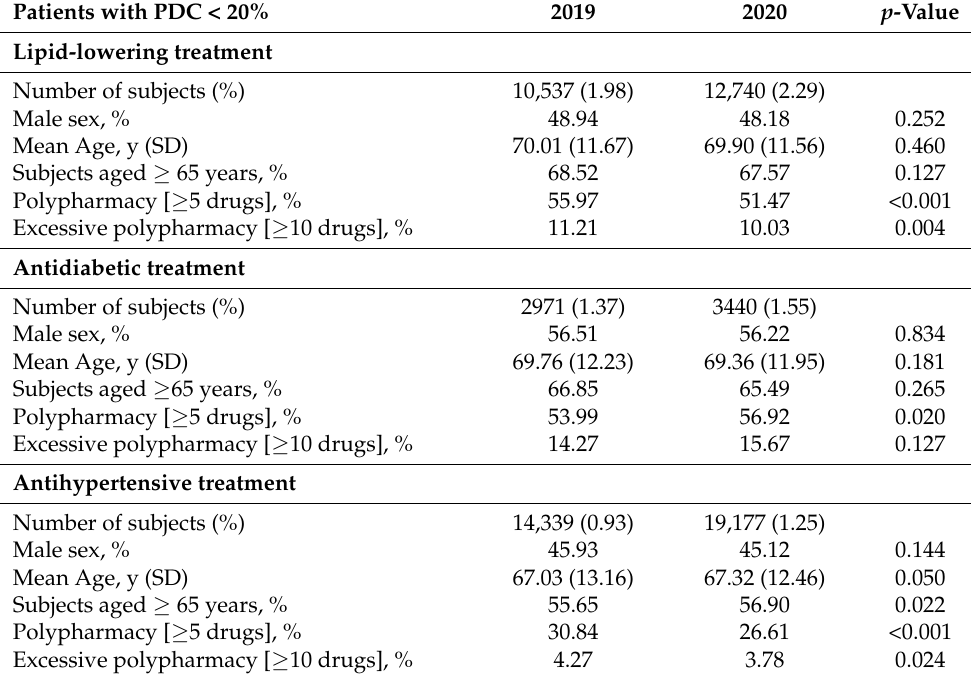
Table 2. Characteristics of subjects with PDC < 20% at the end of the P2–P3 period for each year and by the three chronic therapies, among those with high adherence in